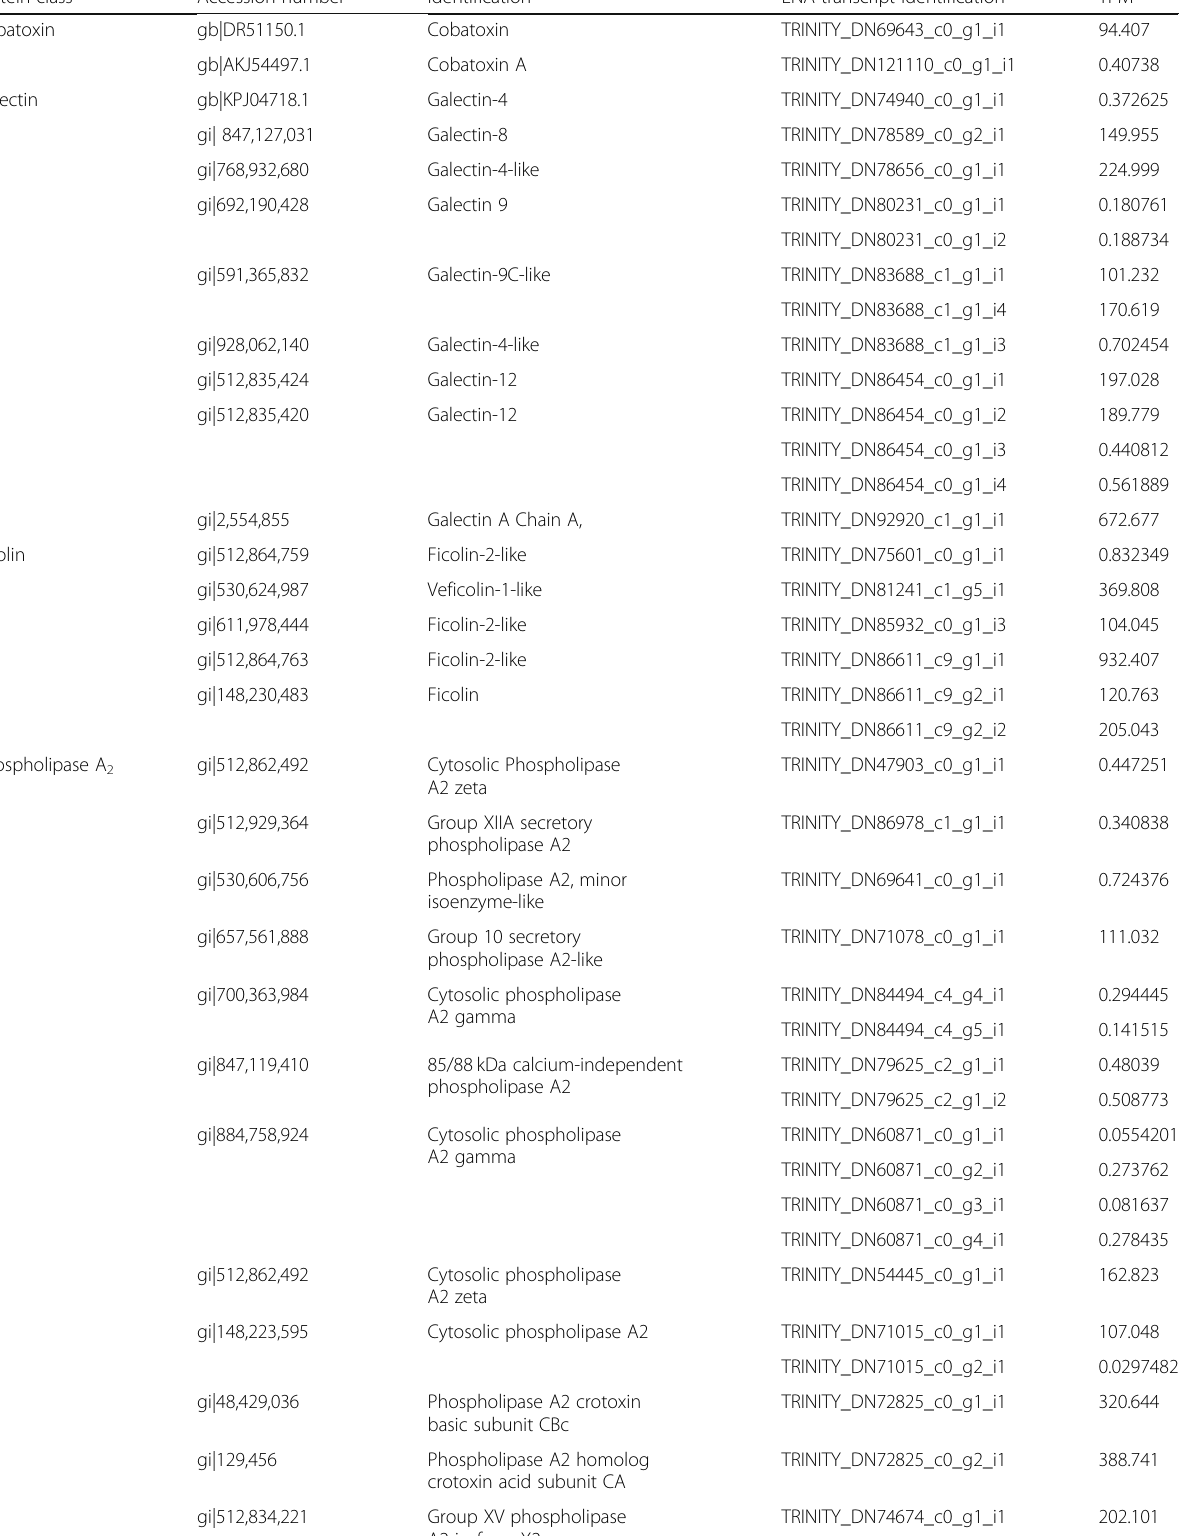
Table 3 List of other peptides and protein of interest from the transcriptome Protein